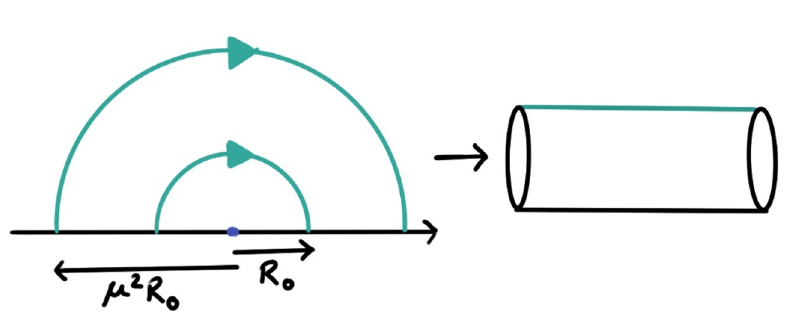
Figure 4. The t = 0 slice of the two-sided BTZ obtained by quotienting the upper half plane by